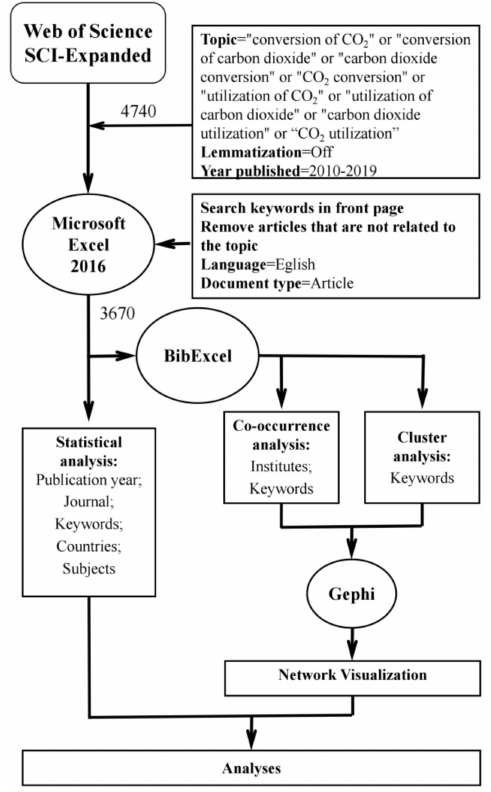
Figure 8. The general flow diagram for systematic bibliometric